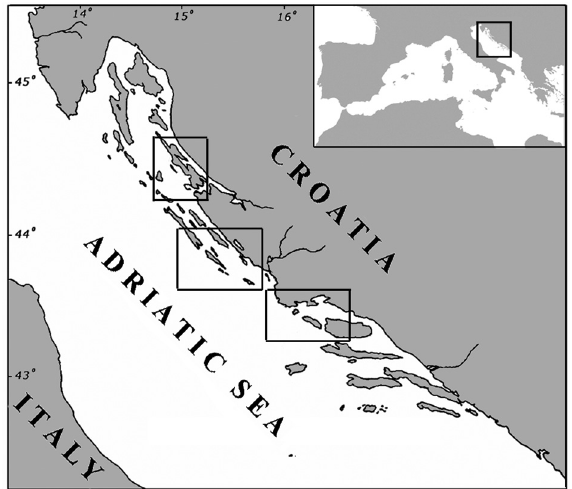
Fig . 1. – Map of the eastern Adriatic Sea (north-central Mediter- ranean). The boat seine fishing grounds in this study are